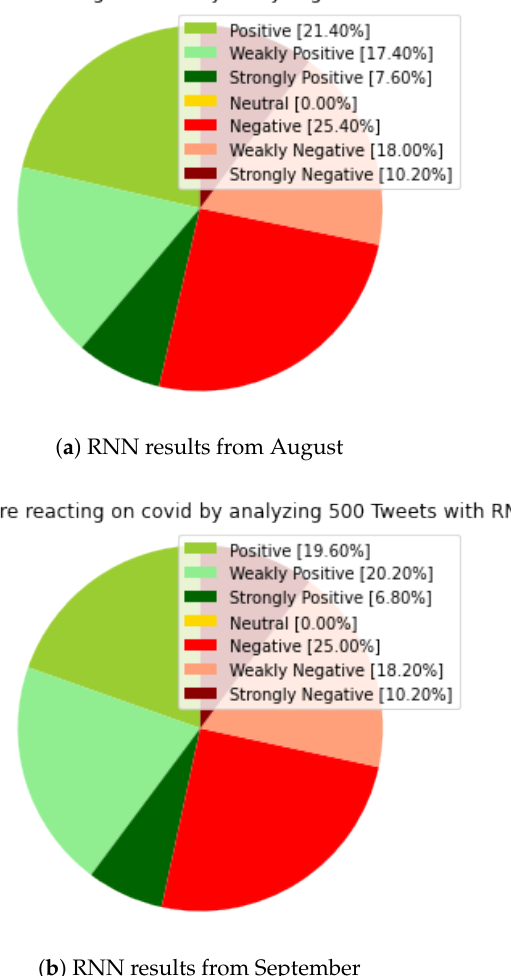
Figure 4. Analysis of sample of 500 tweets by RNN, using “COVID” keyword. The time periods stands between 29 August 2021 and 31 August 2021, and 2 September 2021 and 4 September